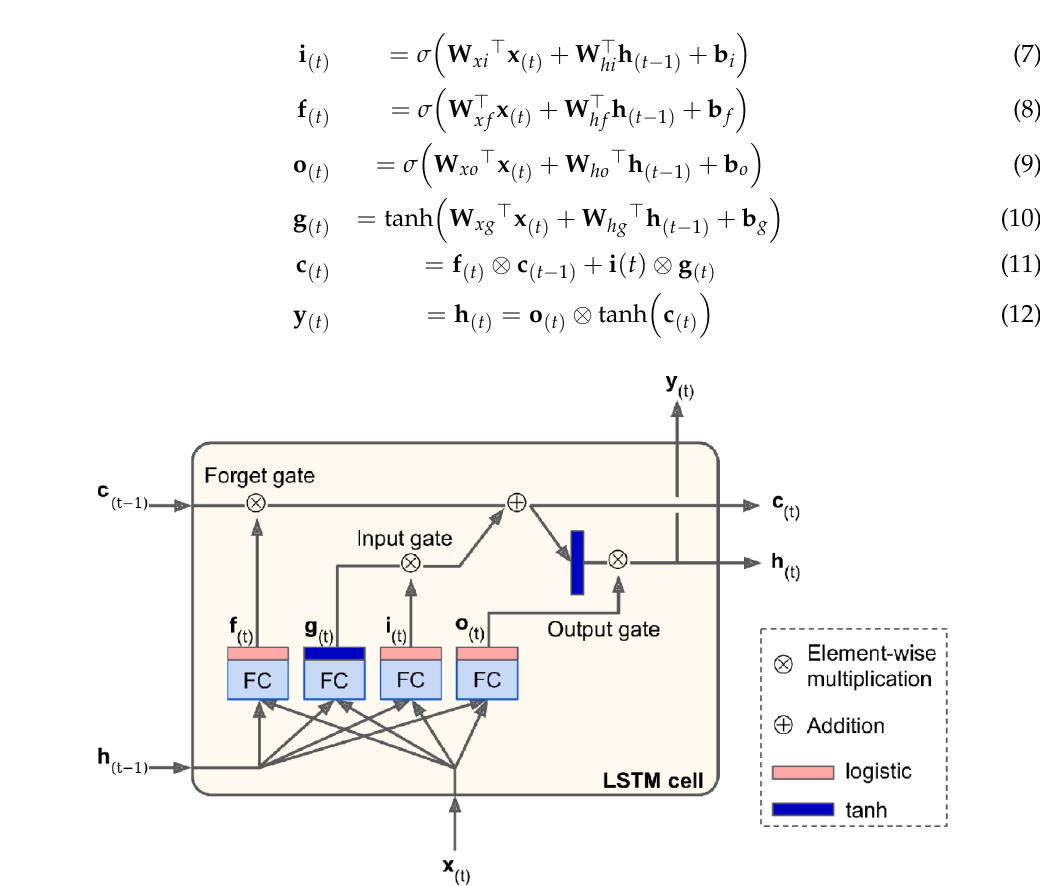
Figure 4. The LSTM cell improves upon the basic recurrent neural network with a series of gates to selectively remember and forget information passing through. FC stands for fully connected layer, which is internal to the cell, not the layers in Figure